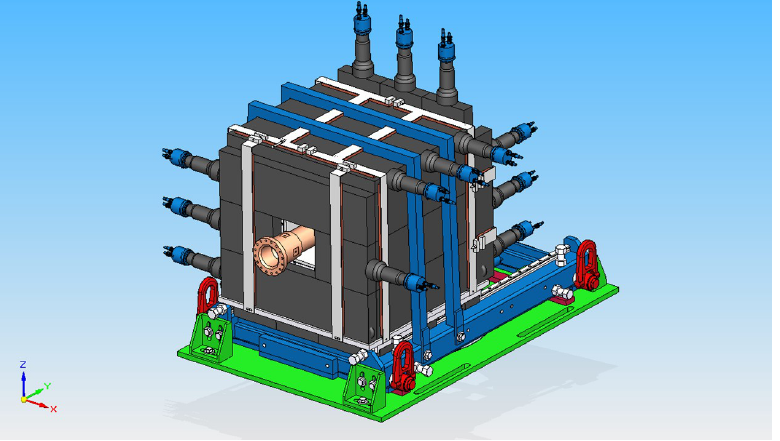
Figure 19. Perspective of the detector with the passive and active shield showing the 4 π sr